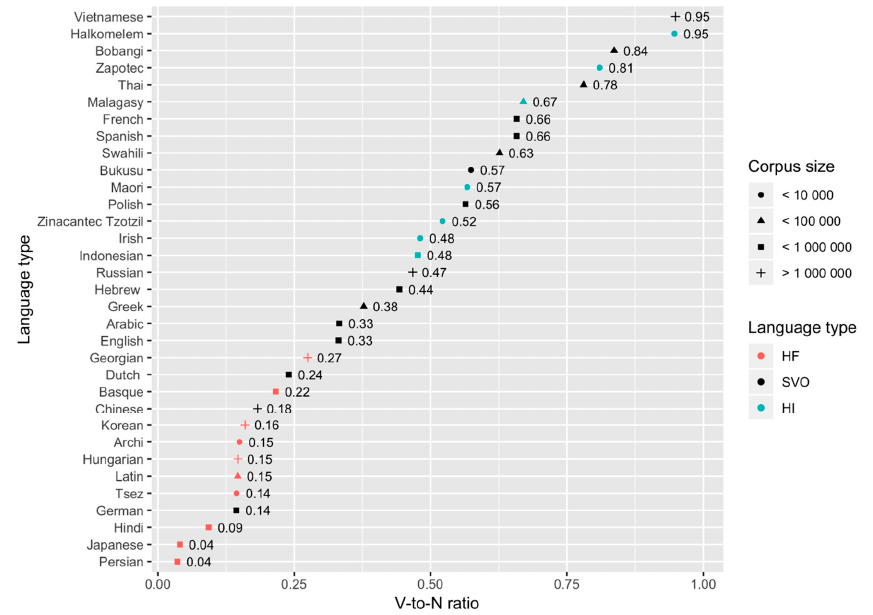
Figure 2. Verb-to-noun ratios: head-final languages, head-initial languages, and SVO languages (total 33 languages). Corpus size indicated with the dot shape.